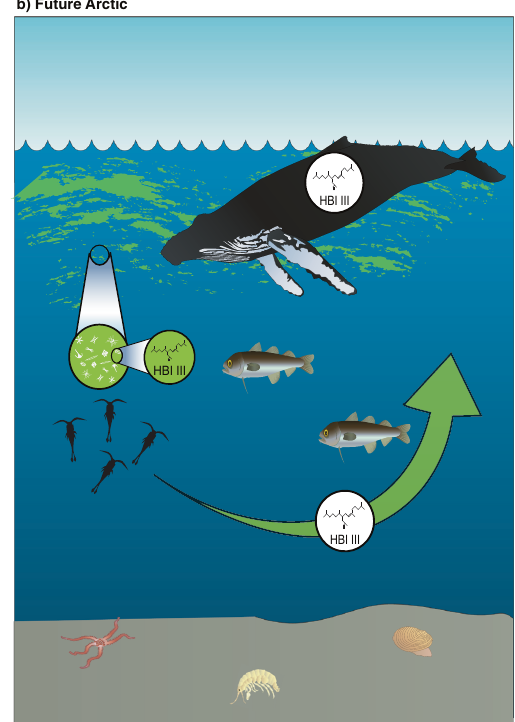
removedandreplacedexclusivelybythetransferofpelagiccarbon(asindicatedby HBI III). Algal community composition has shifted, including introduction of new species and reduced biomass and abundance, as a result of these changes in the food web. Symbols courtesy of the Integration and Application Network (ian.um- ces.edu/media-library) licensed under CC BY-SA 4.0 (polar bear, humpback whale, mixed phytoplankton, pennate diatom, Gammarus amphipod, clam – Tracey Saxby; Arctogadus glacialis – Kim Kraeer, Lucy Van Essen-Fischer; diatoms – Diana Kliene, Marine Botany